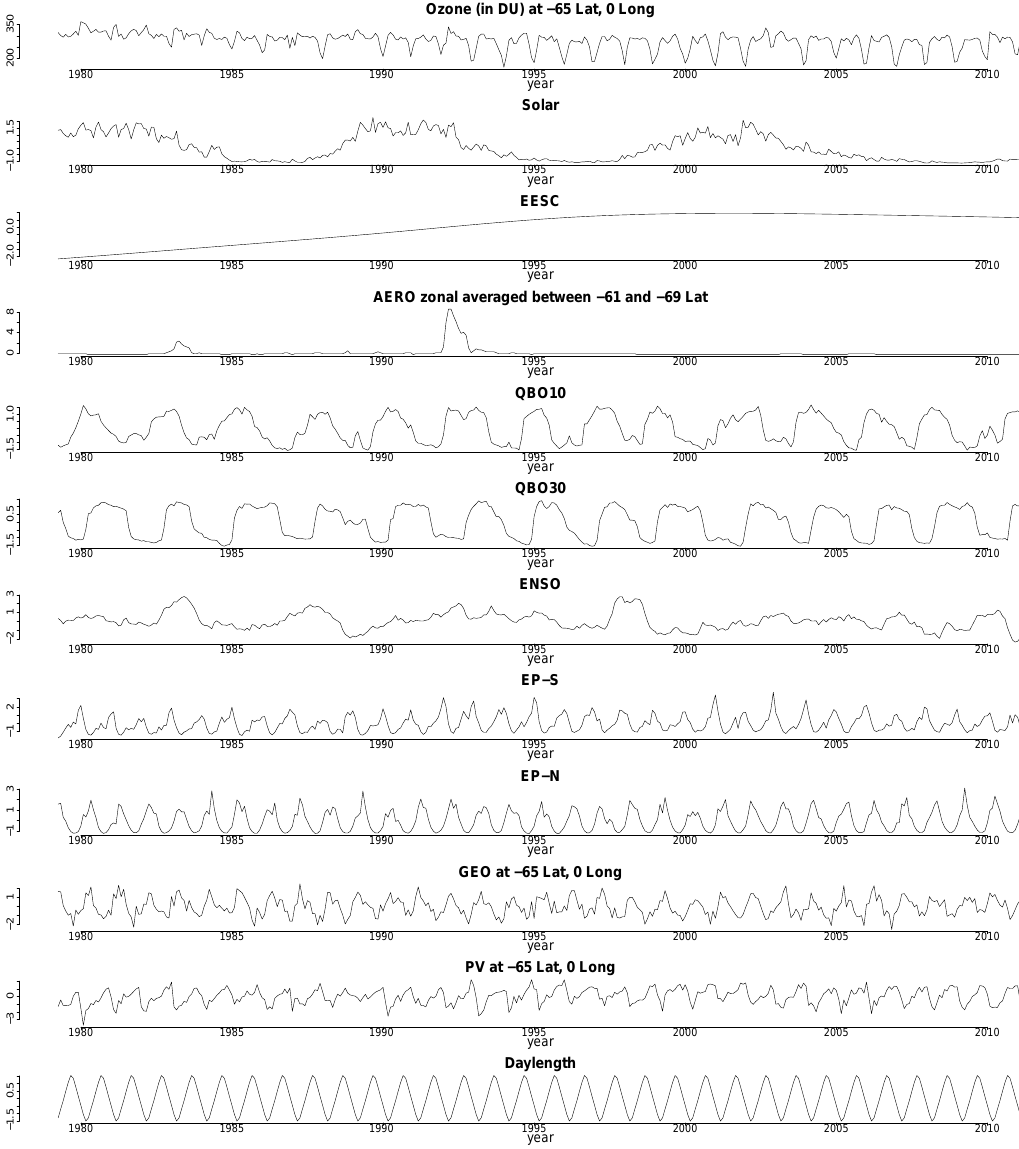
Figure 1. Time series of ozone and explanatory variables for the period 1979–2010 at 65 ◦ S and 0 ◦ E. The explanatory variables are normal- ized prior to plotting. QBO10 and QBO30 represent the QBO index at 10 and at 30hPa,